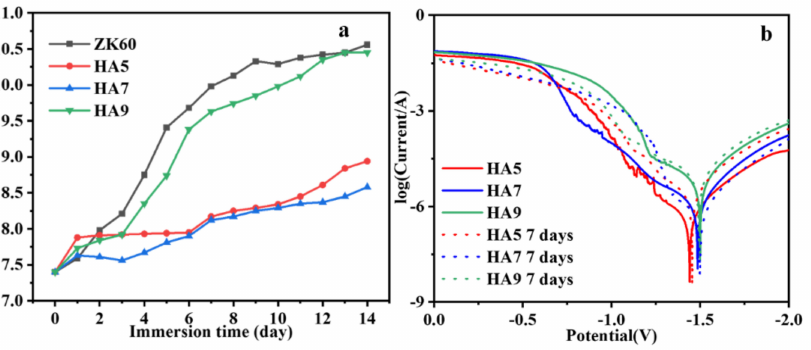
Figure 6. ( a ) Variation of pH of Hank’s solution containing immersed sample. ( b ) Polarization curves of the immersed HA samples.